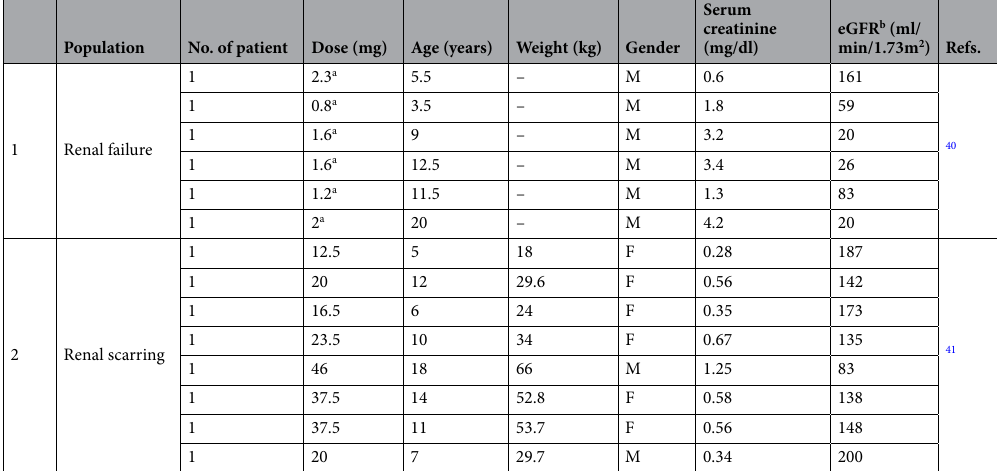
Table 1. Pediatric data used for the development of the PBPK model. a DOSE unit in mg/kg. b